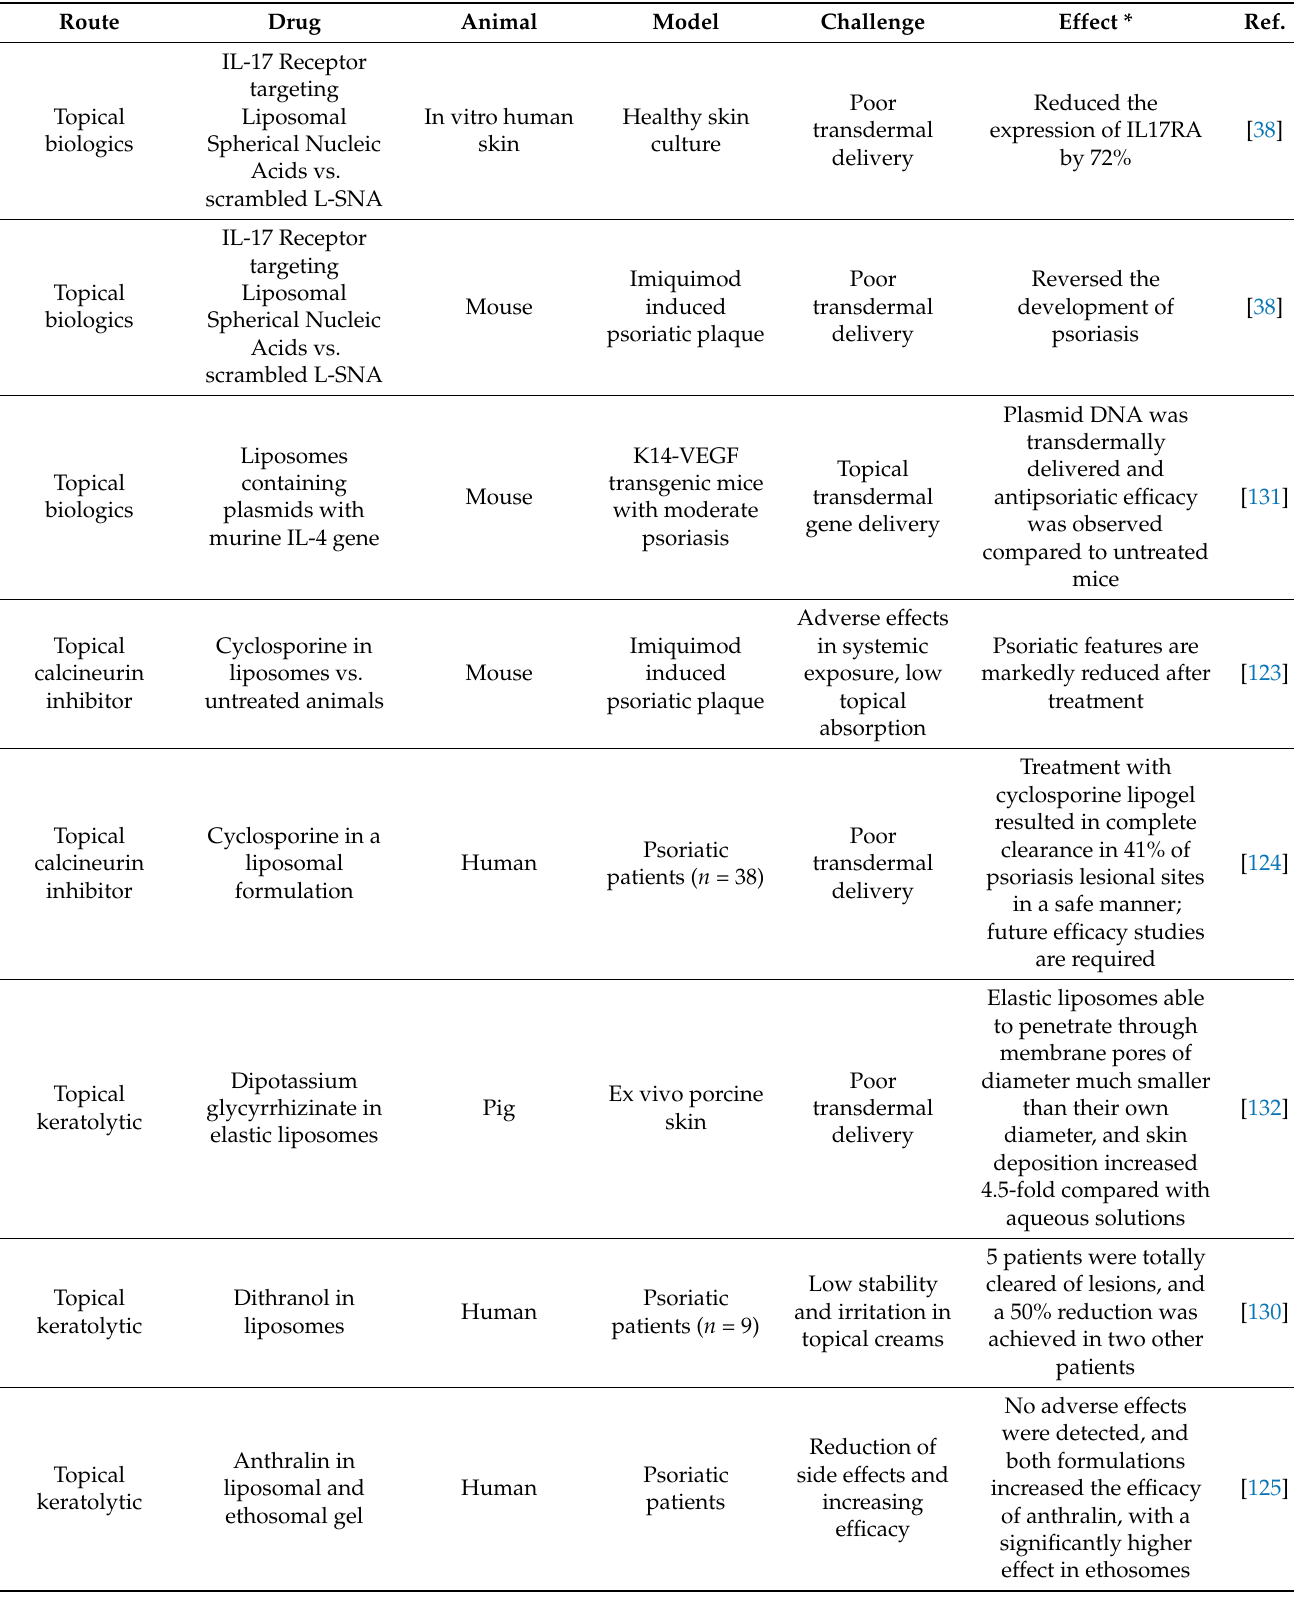
Table 2. Overview of innovative research using liposome-based topical drug delivery in the treatment of psoriasis.